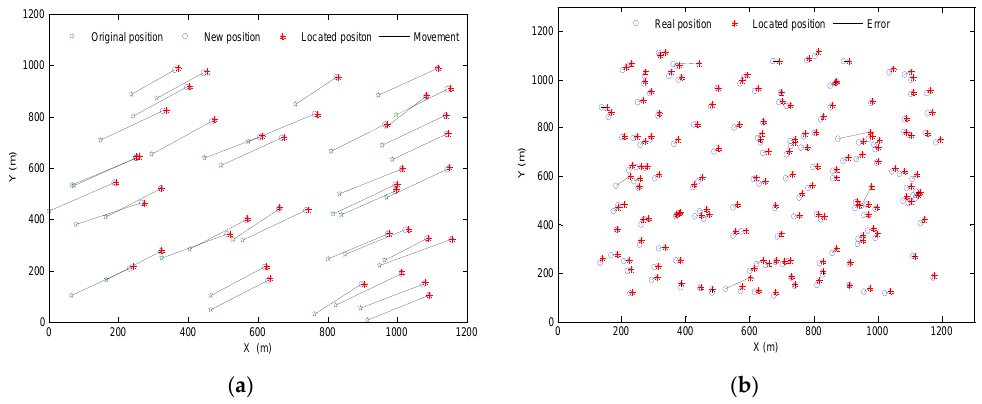
Figure 8. Localization results of ( a ) beacon nodes and ( b ) the unknown nodes.